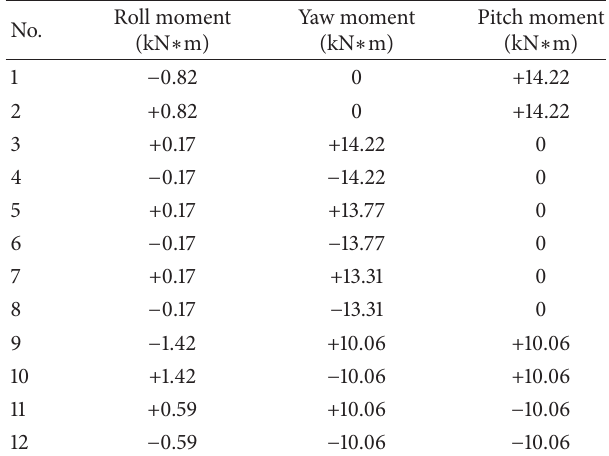
Figure 5: The response curve of thruster model to control com- mand.